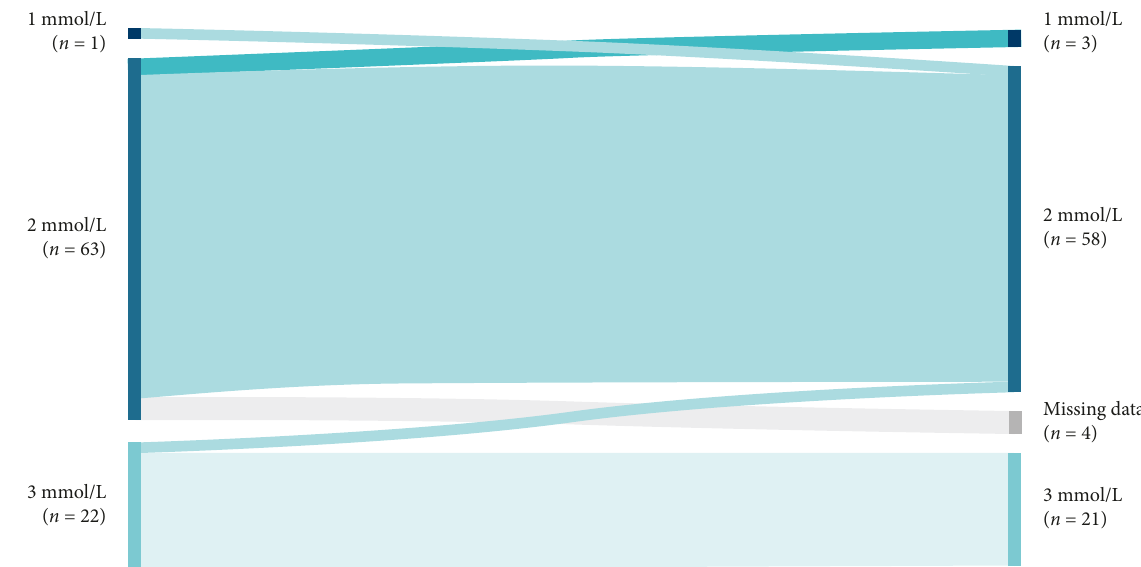
Figure 6: Shift in dK + concentration category of 1, 2, and 3mmol/L from baseline (visit 1, day placebo patients. No imputation of missing data was conducted. Only subjects with visit 4 predialysis sK + measurement were included. dK + , dialysate potassium; EOT, end of treatment; sK + , serum